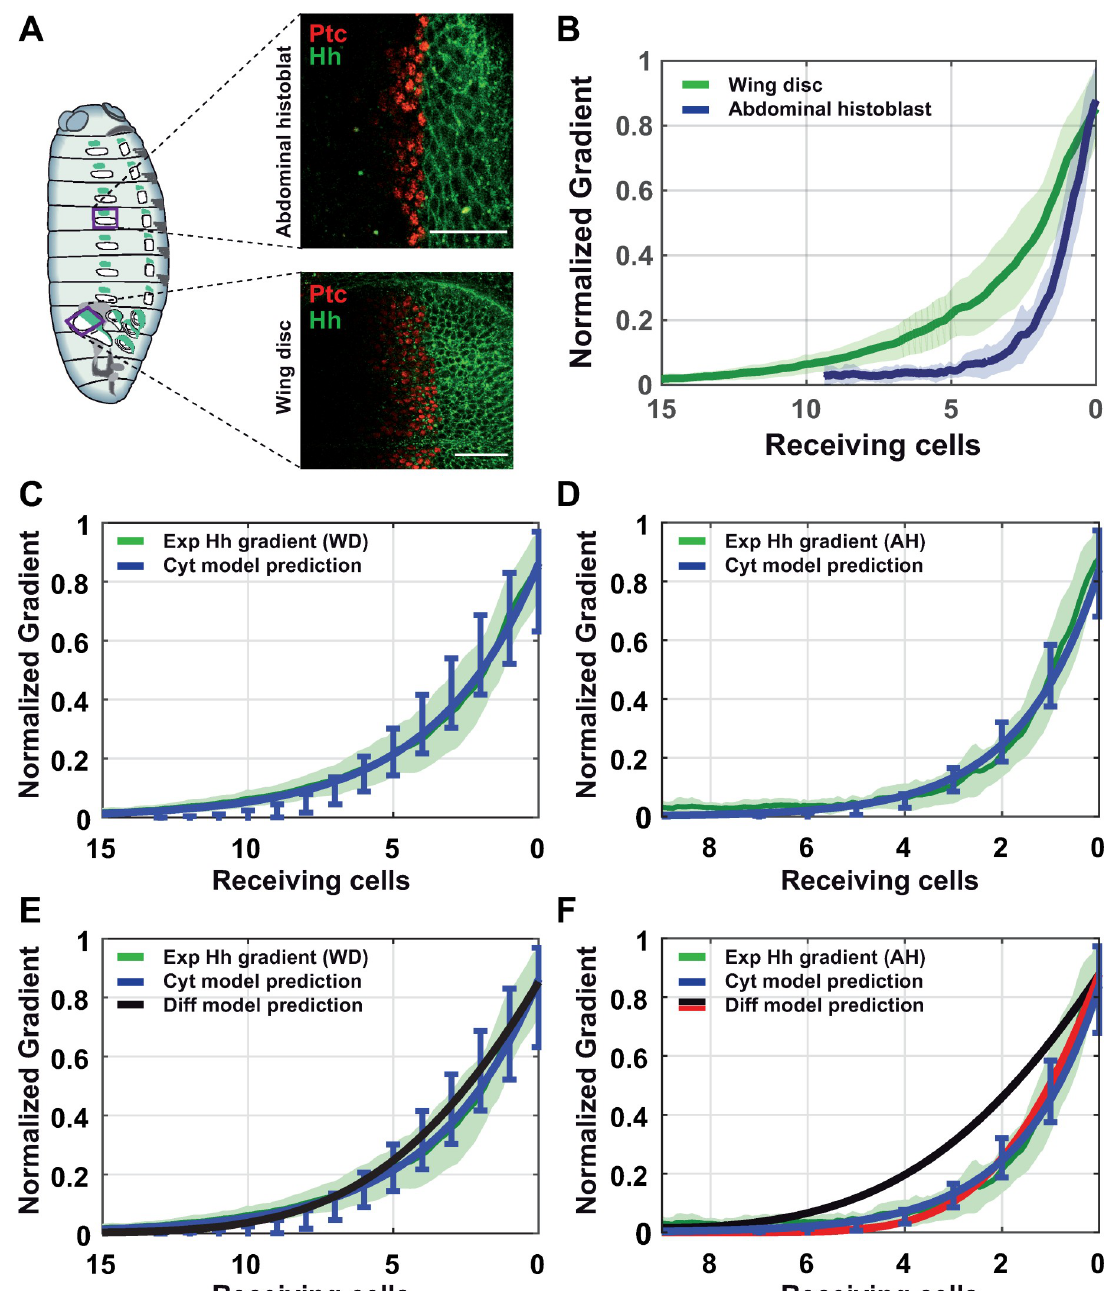
Fig 4. Experimental and simulated Hh gradients in Drosophila tissues. (A) Confocal sections of Drosophila epithelia labeled with Hh : GFP BAC and EnhancerPtcRed . Top: abdominal histoblast nest. Bottom: imaginal wing disc. (B) Quantified data of the Hh gradient in both epithelia: wing disc (green) and abdominal histoblast nest (blue). (C) Comparison between the wing disc experimental gradient (green) and the predicted gradient estimated by our cytoneme model (blue). (D) Comparison between the abdominal histoblast nest experimental gradient (green) and the predicted gradient estimated by cytoneme model (blue). (E) Comparison between the wing disc experimental gradient (green) and the predicted gradients applying different models: cytoneme model (blue) and diffusion-degradation model (black). (F) Comparison between the abdominal histoblast experimental gradient (green) and the predicted gradients applying different models: cytoneme model (blue) and diffusion-degradation model with different diffusion coefficient (red 3 times smaller than black). Scale bars: 30 μ m.